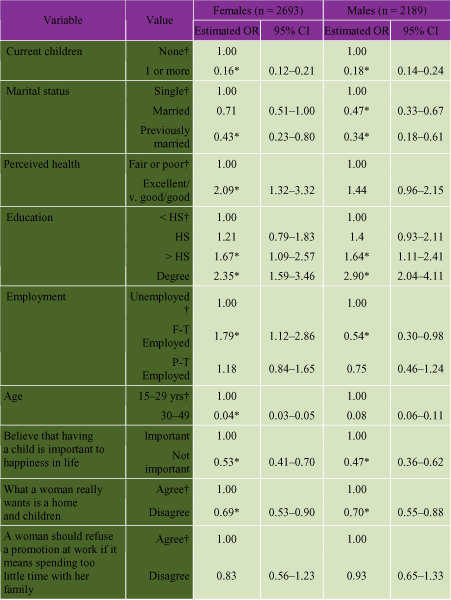
Results of Multivariate Analysis of Factors Associated with Plans to Have One or More Children in the Future Rescaled Weight Used. Data Source: GSS Cycle 10, 1995